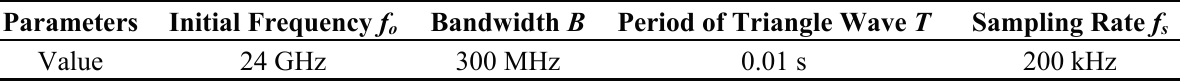
Table 2. Radar parameters.